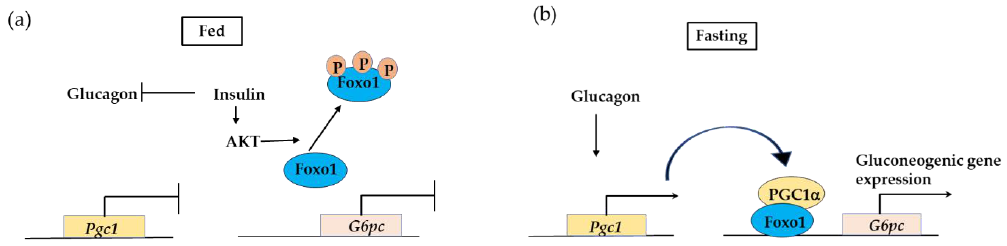
Figure 7. PGC1 α –FOXO1 complex regulates expression of glucogenic genes. ( a ) Under the fed condition, insulin acts to suppress Pgc1 expression and inactivate FOXO1 complex, leading to decreased expression of gluconeogenic genes. ( b ) Under the fasting condition, glucagon induces Pgc1 expression leading to PGC1 α –FOXO1 complex formation and induces glucogenic gene expression.